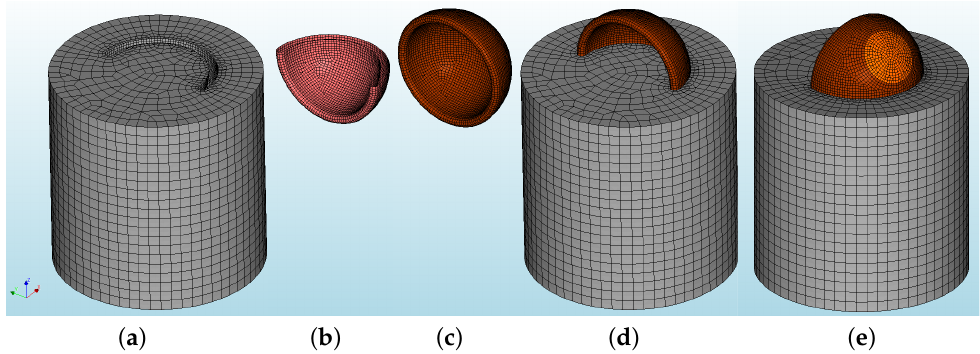
Figure 7. Numerical model’s mesh: ( a ) cement paste cylinder, ( b ) endocarp-cement paste interface, ( c ) crushed endocarp, ( d ) complete model (front), and ( e ) complete model